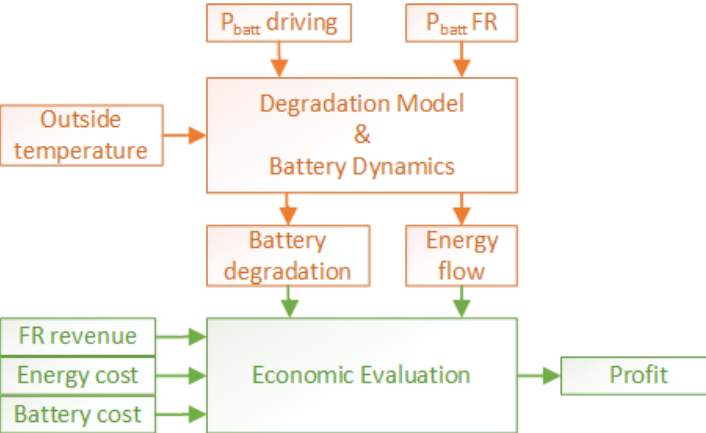
Figure 1. Profit evaluation flowchart: orange for the technical analysis provided in Section 3, green for the economic analysis provided in Section